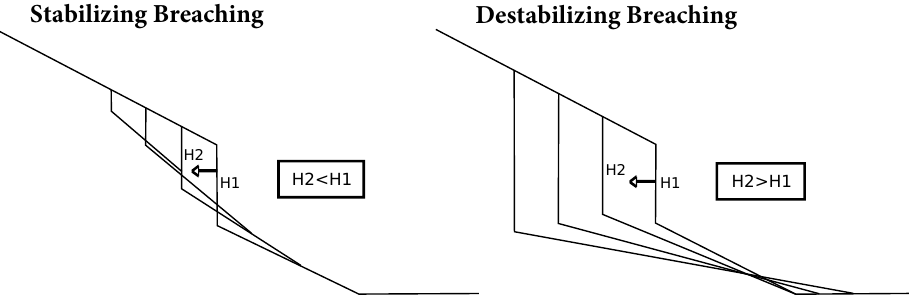
Figure 1. Diagrammatic illustration of the breaching modes, stabilizing breaching ( left ), and destabi- lizing breaching ( right ); H is the breach